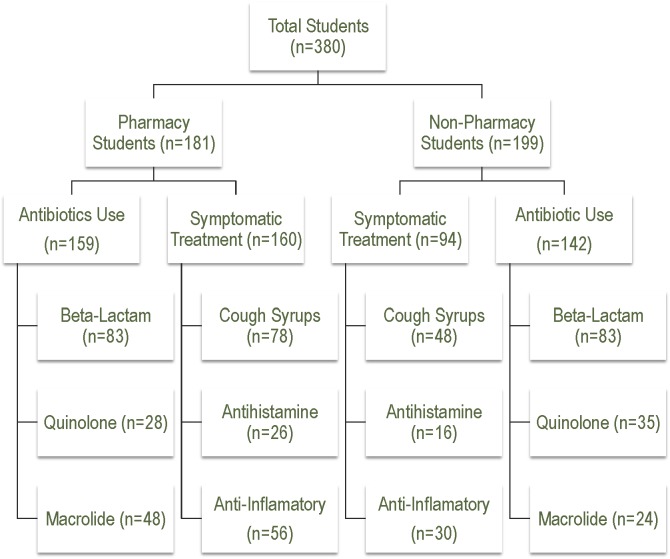
Flow Sheet for Drug Usage Among University Students.